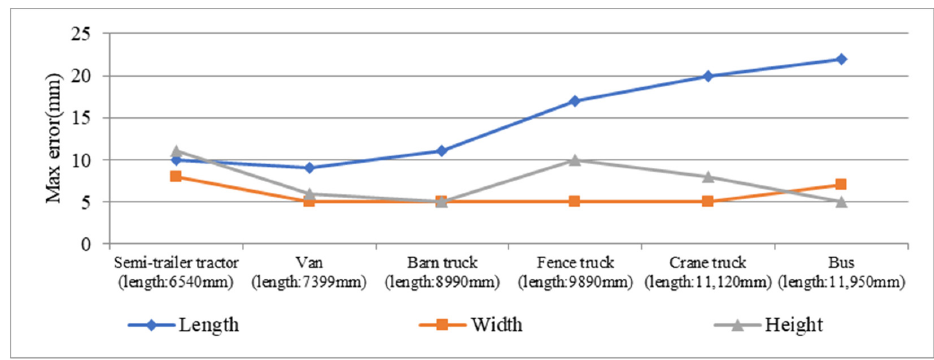
Figure 17. Max error of profile size of the five vehicles.